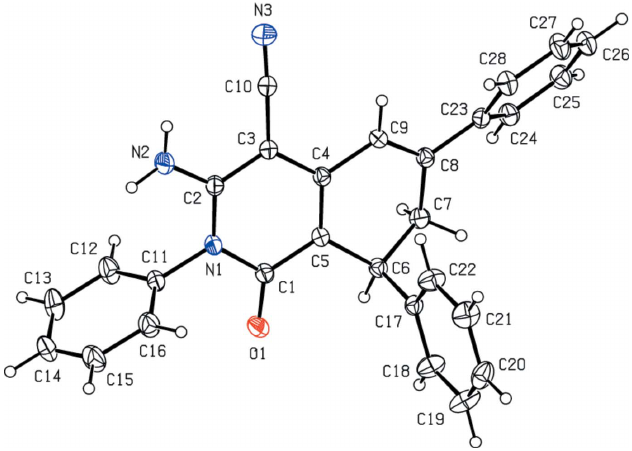
Figure 1 The molecular structure of the title compound. Displacement ellipsoids are drawn at the 30% probability level.